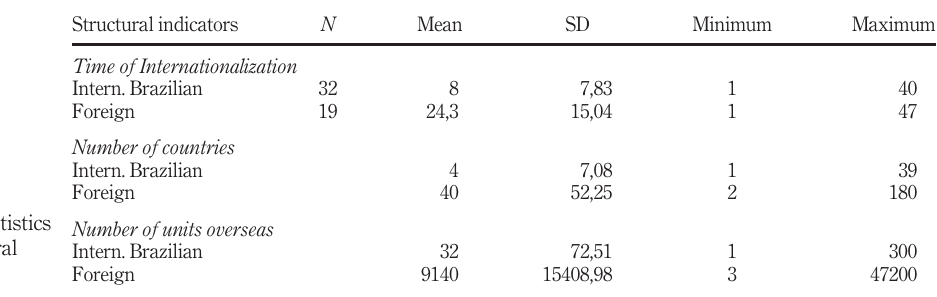
for the structural